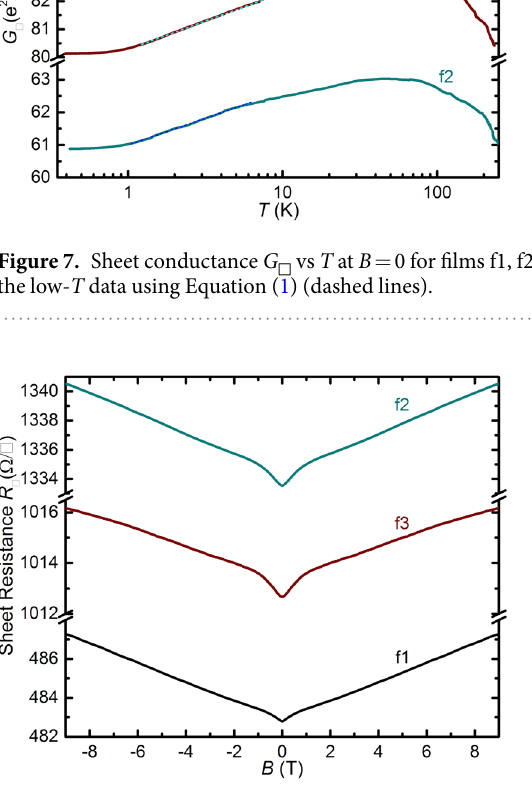
Figure 8. Sheet resistance R vs B at T = 0.39 K for films f1, f2 and f3 (films as indicated). A positive MR □ attributed to antilocalization is visible for B < 1 T, and a linear positive MR appears for B > 1.5